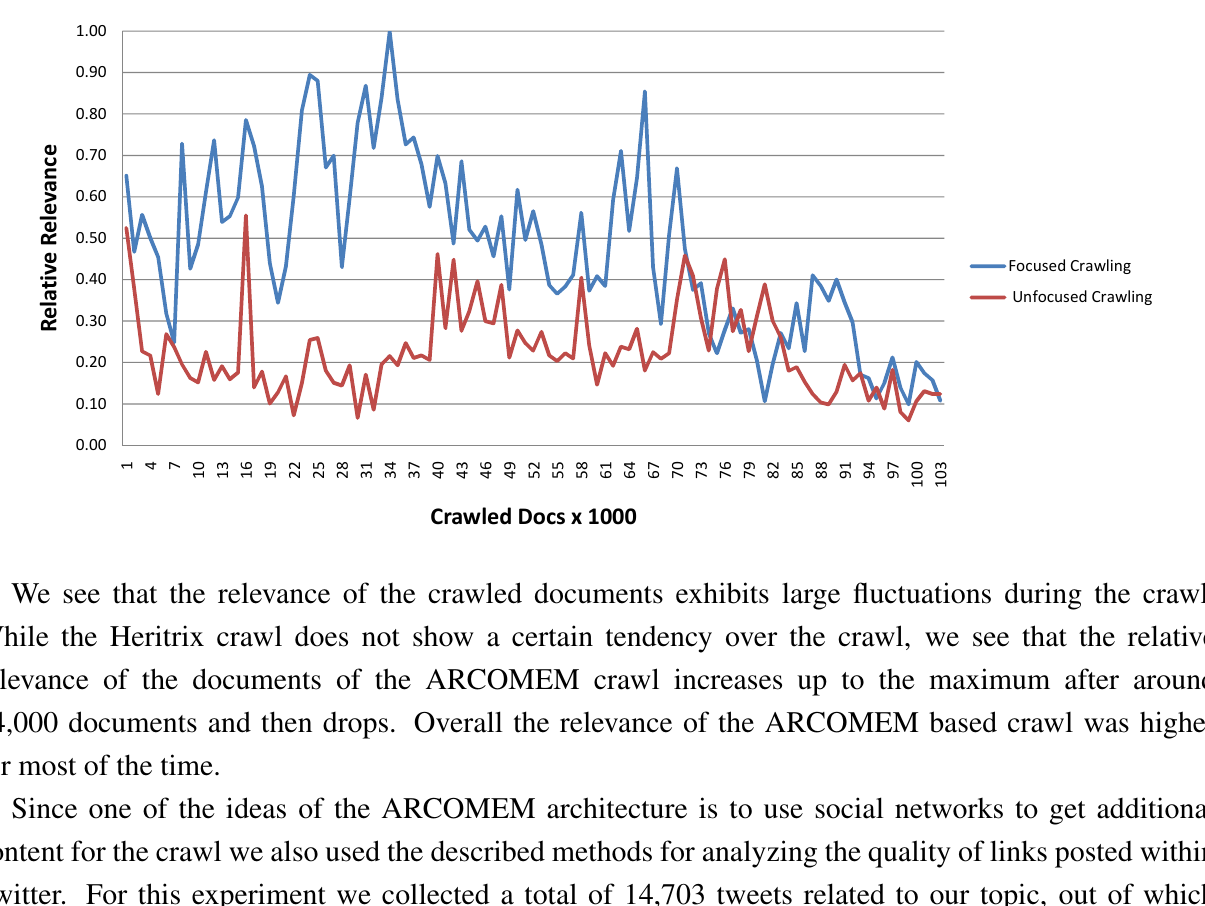
Figure 8. Focused (ARCOMEM) and unfocused (Heritrix) crawling over